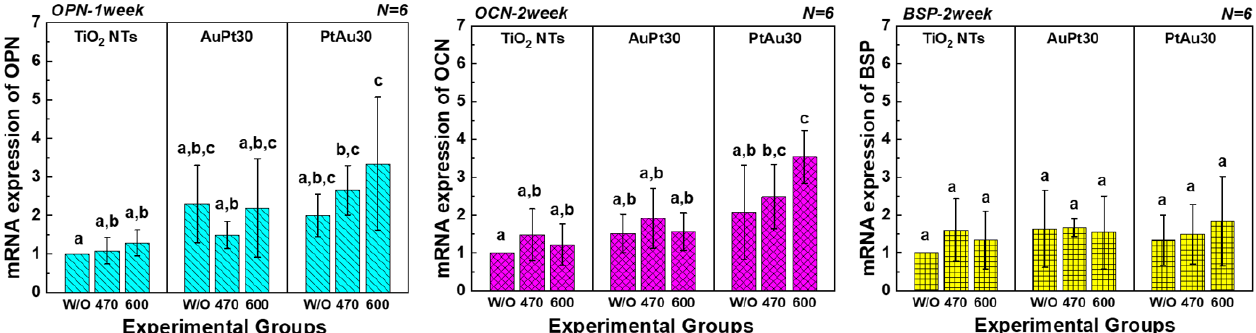
Figure 8. The mRNA expression of OPN, OCN, and BSP of the hMSCs cultured on Au and Pt multi-coated TiO 2 nanotubes analyzed by quantitative real-time PCR assay. In the graph, W/O, 470, and 600 designate no irradiation, 470 nm irradiation, and 600 nm irradiation, respectively. Moreover, in each graph, the values of experimental groups with the same lowercase letter (a, b, or c) are not statistically different as determined by one-way ANOVA at α = 0.05.